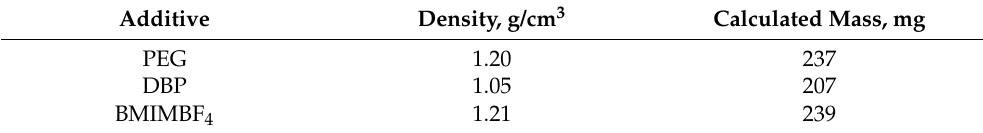
Table 1. Pore-forming additives.